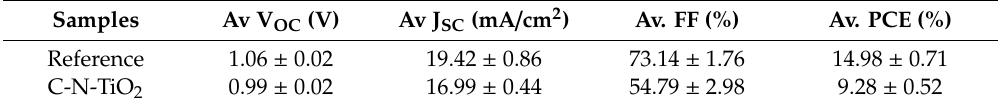
Table 6. Averaged (Av.) electrical parameter values and standard deviation calculated over six devices.